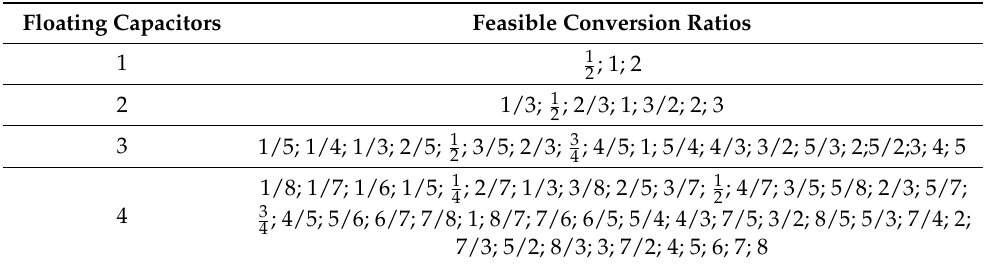
Table 1. Number of floating capacitors (N − 1) VS feasible conversion ratios (m) [21]. Reproduced from [21], In Proceedings of the IEEE Power Electronics Specialists Conference: